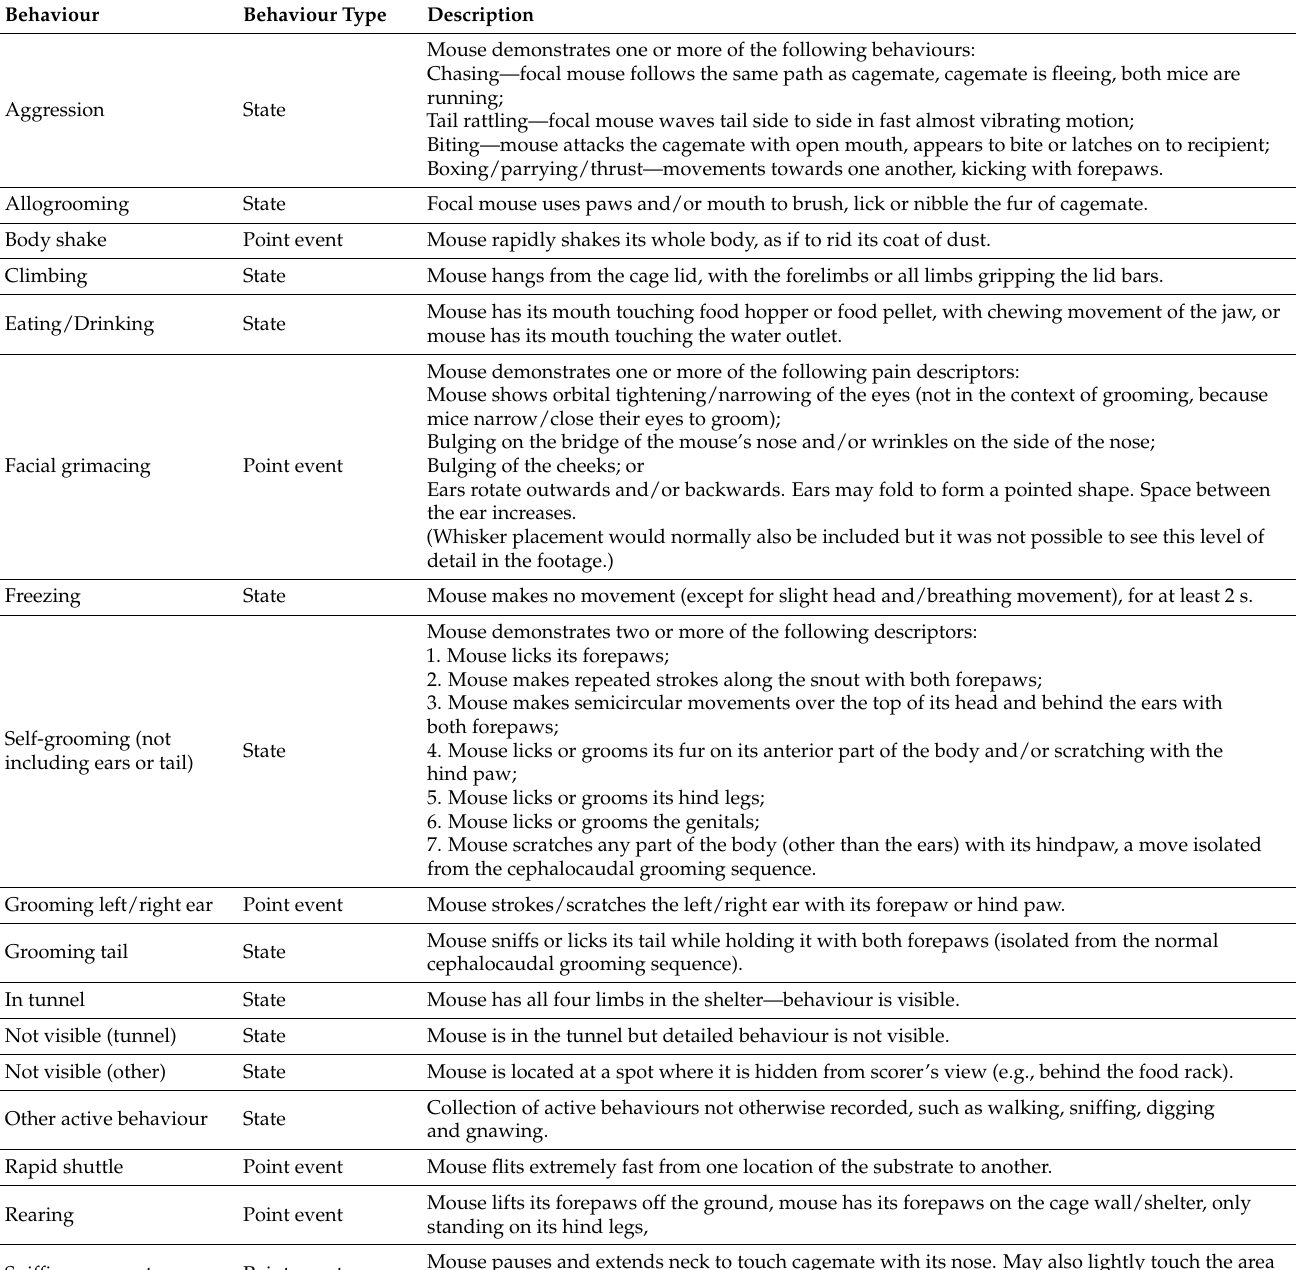
Table 1. Ethogram for coding homecage video recordings following treatment procedure. The ethogram was adapted from existing publications [20,30,31] and from pilot observations. The behaviours are listed in alphabetical order. Behavioural coding was done on one individual mouse at a time, so each video clip was observed twice to allow behavioural coding for both mice in a cage. Point events were recorded as frequencies only, whilst states were recorded as both frequencies and